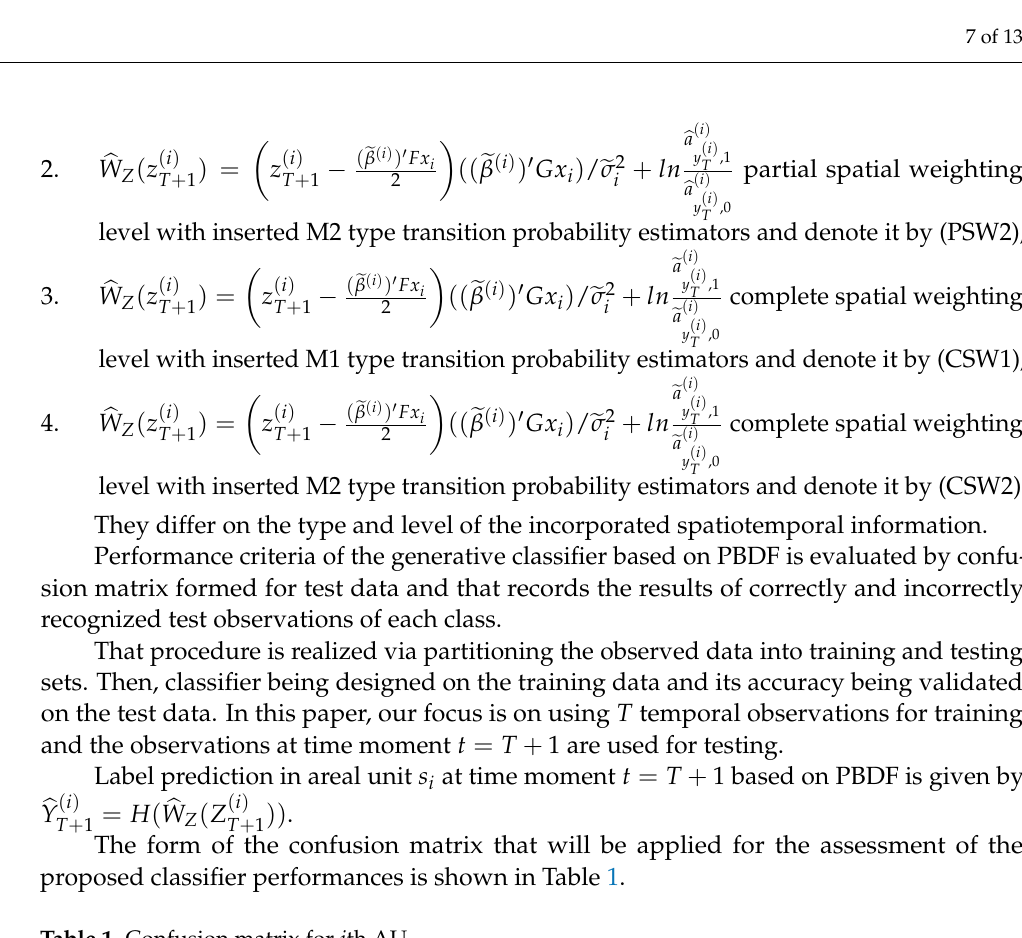
Table 1. Confusion matrix for i th